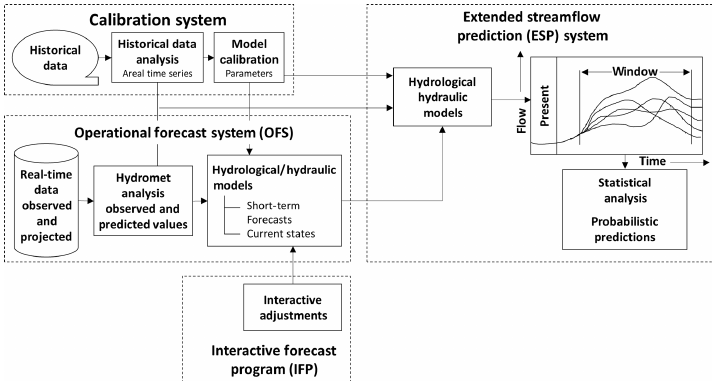
Figure 1. Overall structure chart of China National Flood Forecasting